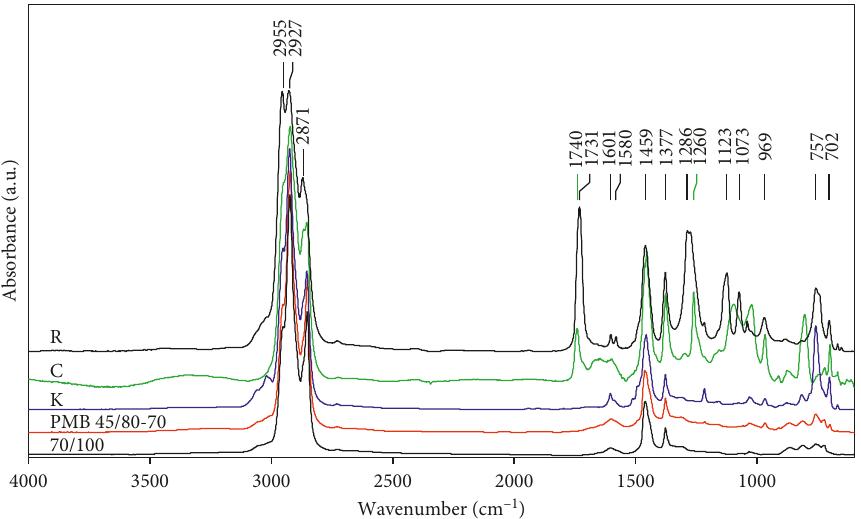
Figure 1: FTIR spectra for the selected binders in the range 4000–600cm − 1 .